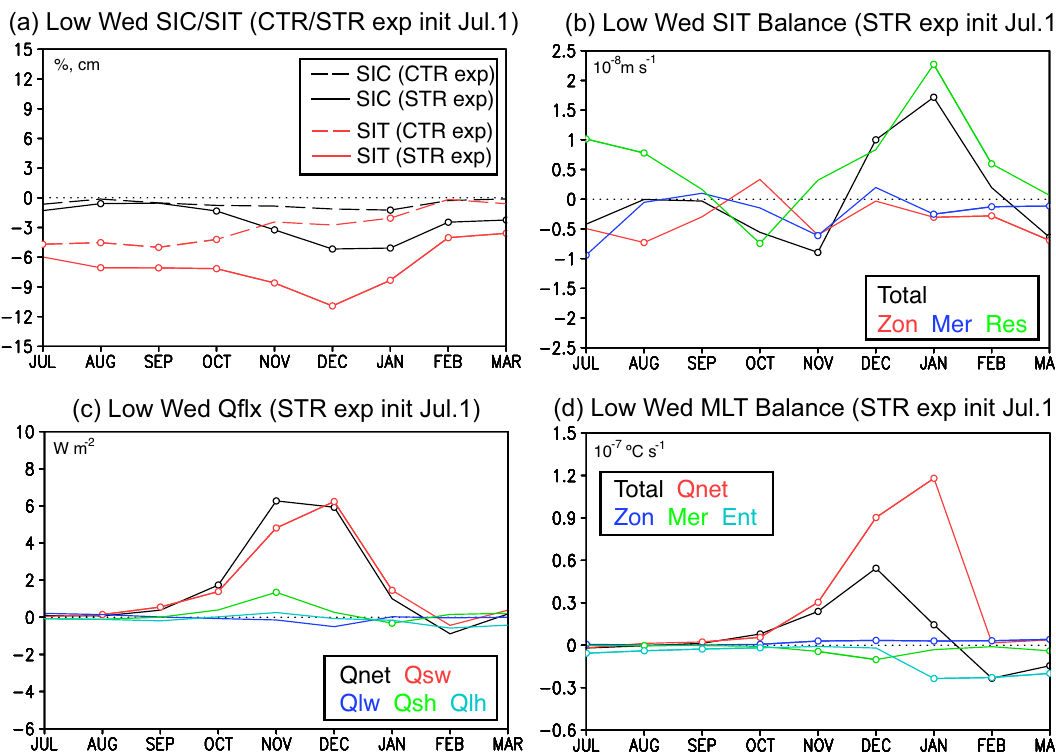
Figure 7. ( a ) Temporal evolution of composite SIC (black lines in %) and SIT (red lines in cm) anomalies in the Weddell Sea (70° S–60° S, 55° W–40° W; see the black boxes in Fig. 6) predicted from July 1st in the CTR (dashed lines) and STR (solid lines) experiments for low sea-ice years of the Weddell Sea. Open circles indicate anomalies that are statistically significant at 98% confidence level using the two-tailed Student’s t -test. ( b ) Same as in ( a ), but for composite anomalies of each term in the SIT balance equation (see Eq. (1) in “Methods”). The total SIT tendency (Total; black line in 10 –8 m s −1 ), zonal (Zon; red line) and meridional (Mer; blue line) convergence/divergence, and residual (Res; green line) terms are shown, respectively. ( c ) Same as in ( a ), but for composite anomalies of surface heat fluxes onto the sea ice. Positive values indicate warming of the ocean. The net surface heat flux (Qnet; black line in W m −2 ), shortwave radiation (Qsw; red line), longwave radiation (Qlw; blue line), sensible heat flux (Qsh; green line), and latent heat flux (Qlh; light blue line) are shown, respectively. ( d ) Same as in ( a ), but for composite anomalies of each term in the mixed-layer temperature balance equation (see Eq. (2) in “Methods”). The mixed-layer temperature tendency (Total; black line in 10 –7 °C s −1 ) and contributions from the net surface heat flux (Qnet; red line), zonal (Zon; blue line) and meridional (Mer; green line) advection, and entrainment (Ent; light blue line) terms are shown,